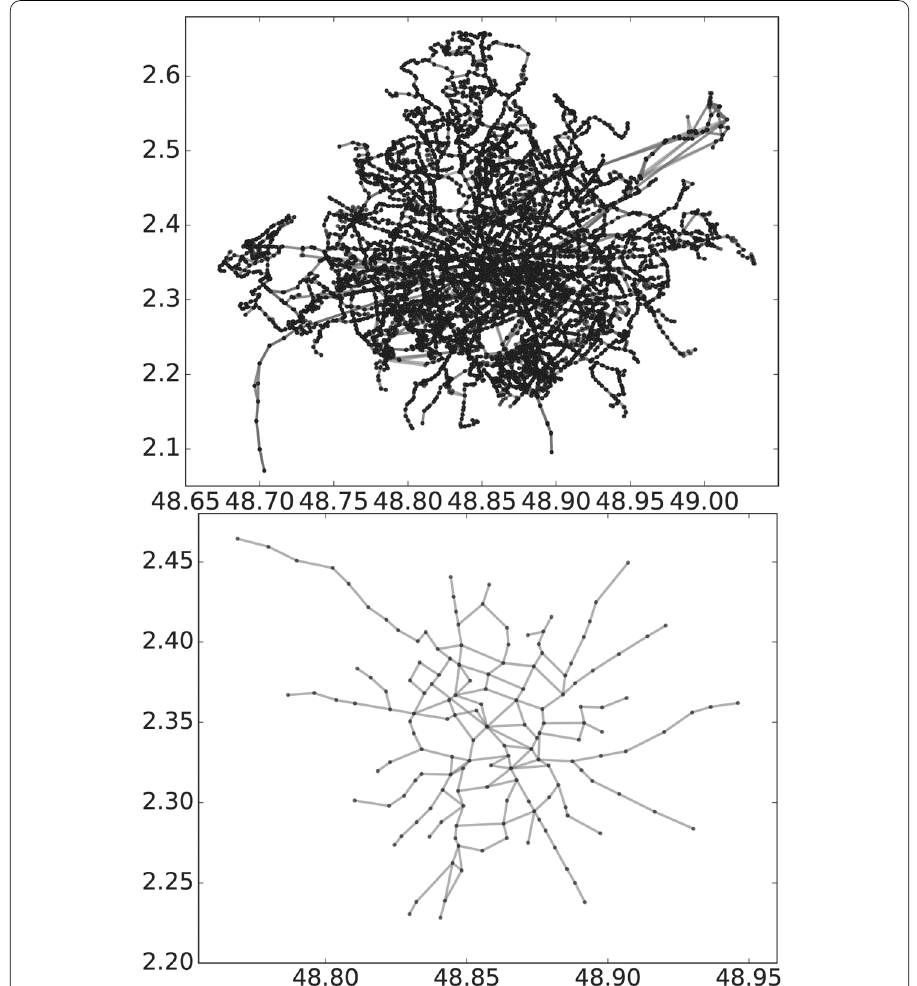
Figure 3 Bus (top panel) and Metro (bottom panel) networks generated from merged GTFS files for the city of Paris. We can clearly see that bus network covers a much larger area than metro network and is much denser than